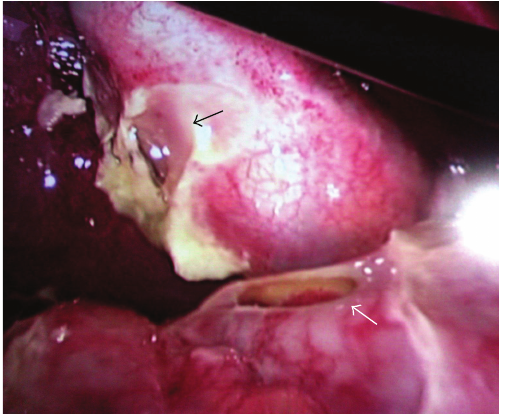
Figure 2: The large duodenal perforation (white arrow) is clearly seen after withdrawing the NG tube. The site of impaction of the NG tube on the gall bladder is also seen (black